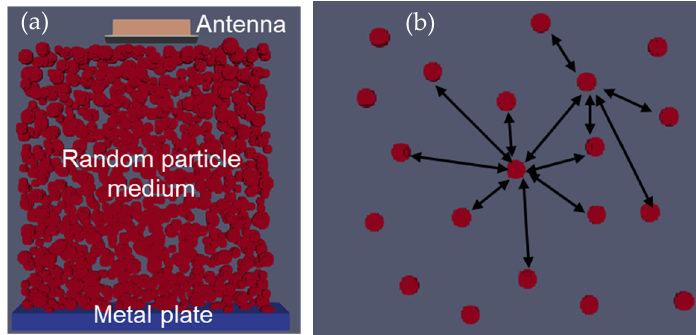
Figure 2. Simulation model of randomly distributed particles: ( a ) Developed from above algorithm, and ( b ) detailed aggregate model with tolerance for aggregate position.